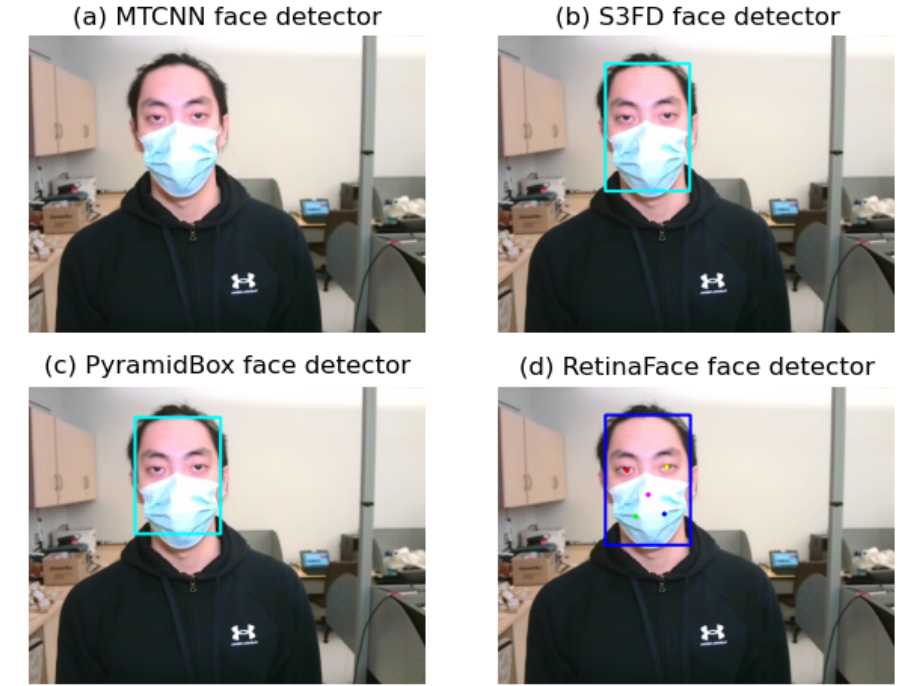
Figure 3. An example of face detection using different detectors ( a ). No face detected by MTCNN face detector, ( b ) face (blue box) detected by S3FD face detector, ( c ) face (blue box) detected by PyramidBox face detector, ( d ) face (blue box) and facial landmarks (colored dots) detected by RetinaFace detector.